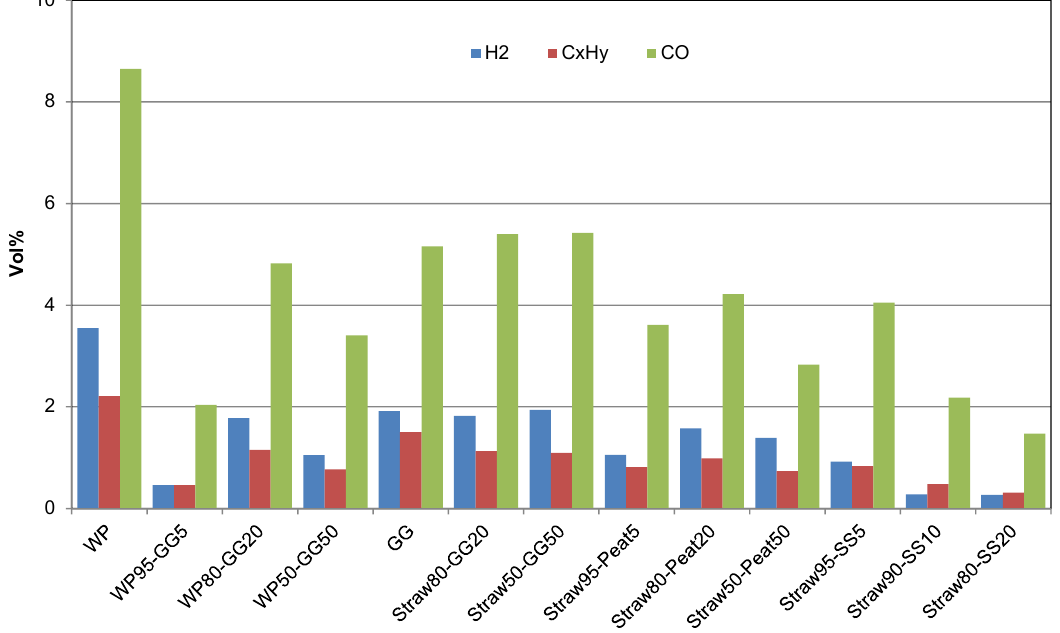
Figure 13. Level of main unburnt species in the primary zone for different fuels and